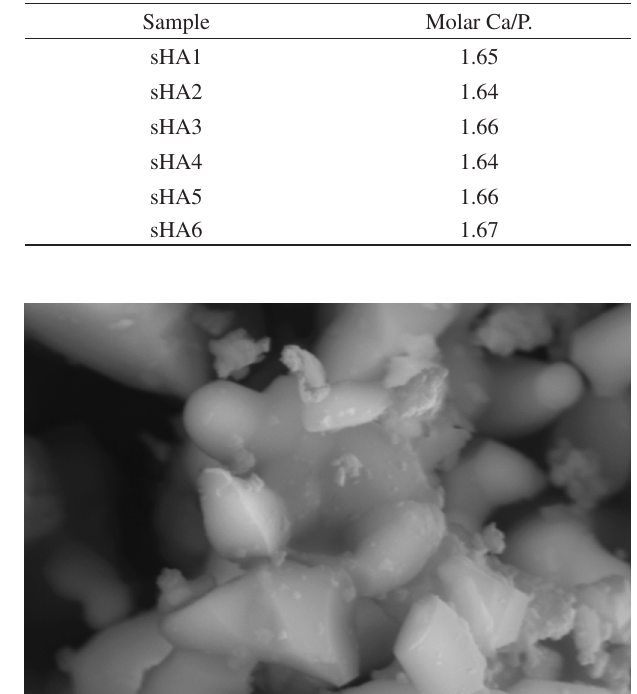
Table 1. Experimental molar Ca/P ratios of sintered